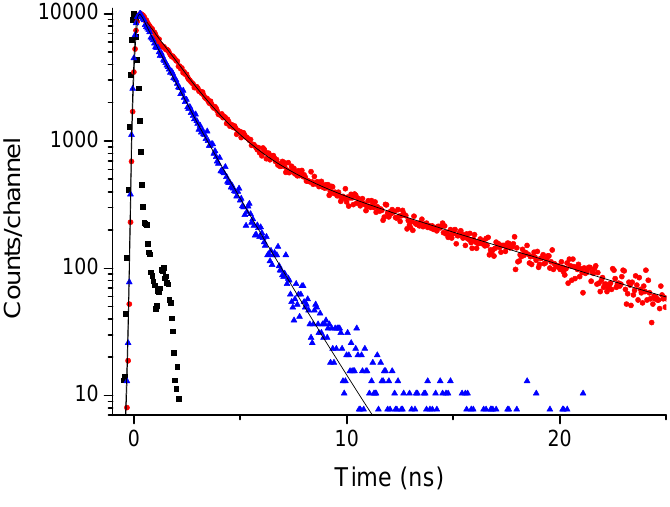
Figure 8. Emission decay of Acetonide-G5-prop-TPPZn (0.050 mM). Red dots: Excited at 403 nm with emission monitored at 650 nm. Blue triangles: Excited at 403 nm with emission monitored at 600 nm. Black squares is system response used for de-convolution fit; slit 32